Question: In one sentence, what is this figure communicating?
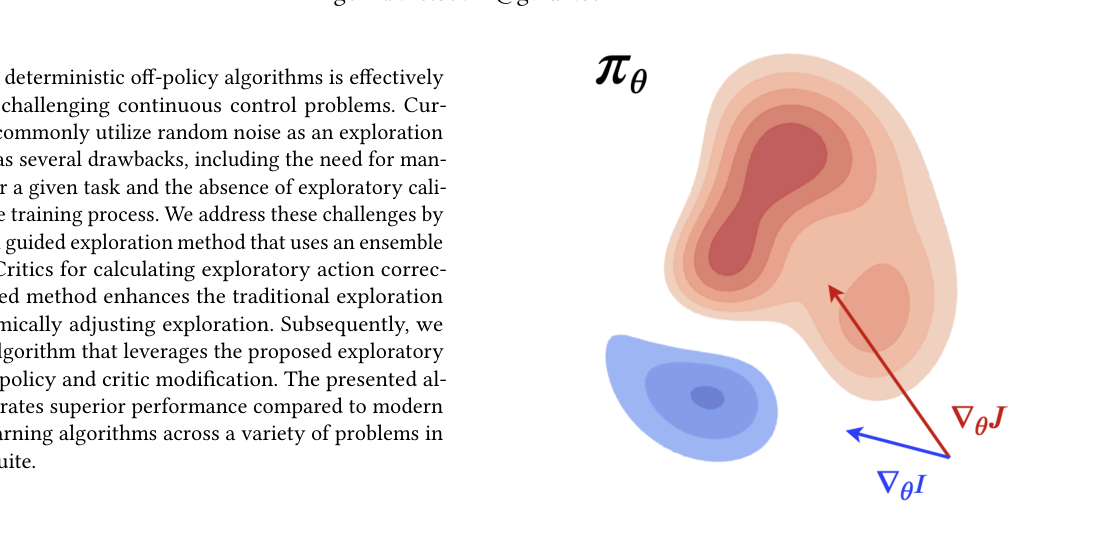
Answer: A scheme of a guided exploration model. Policy gradients ∇𝜃are directed by the final reward objective 𝐽and corrected by an intrinsic objective 𝐼facilitating directed ex- ploration.